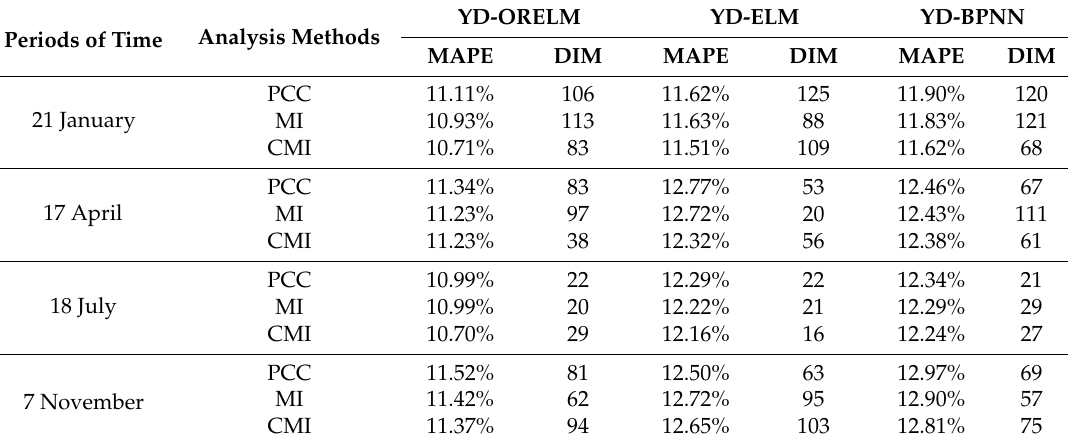
Table 6. The optimal feature subsets of different predict days obtained with YD data.